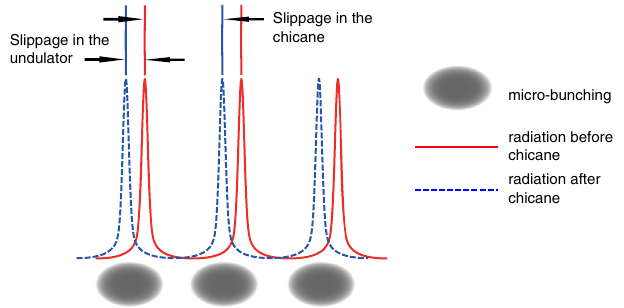
FIG. 2. Principle of the mode-locked amplification for a seeded FEL.